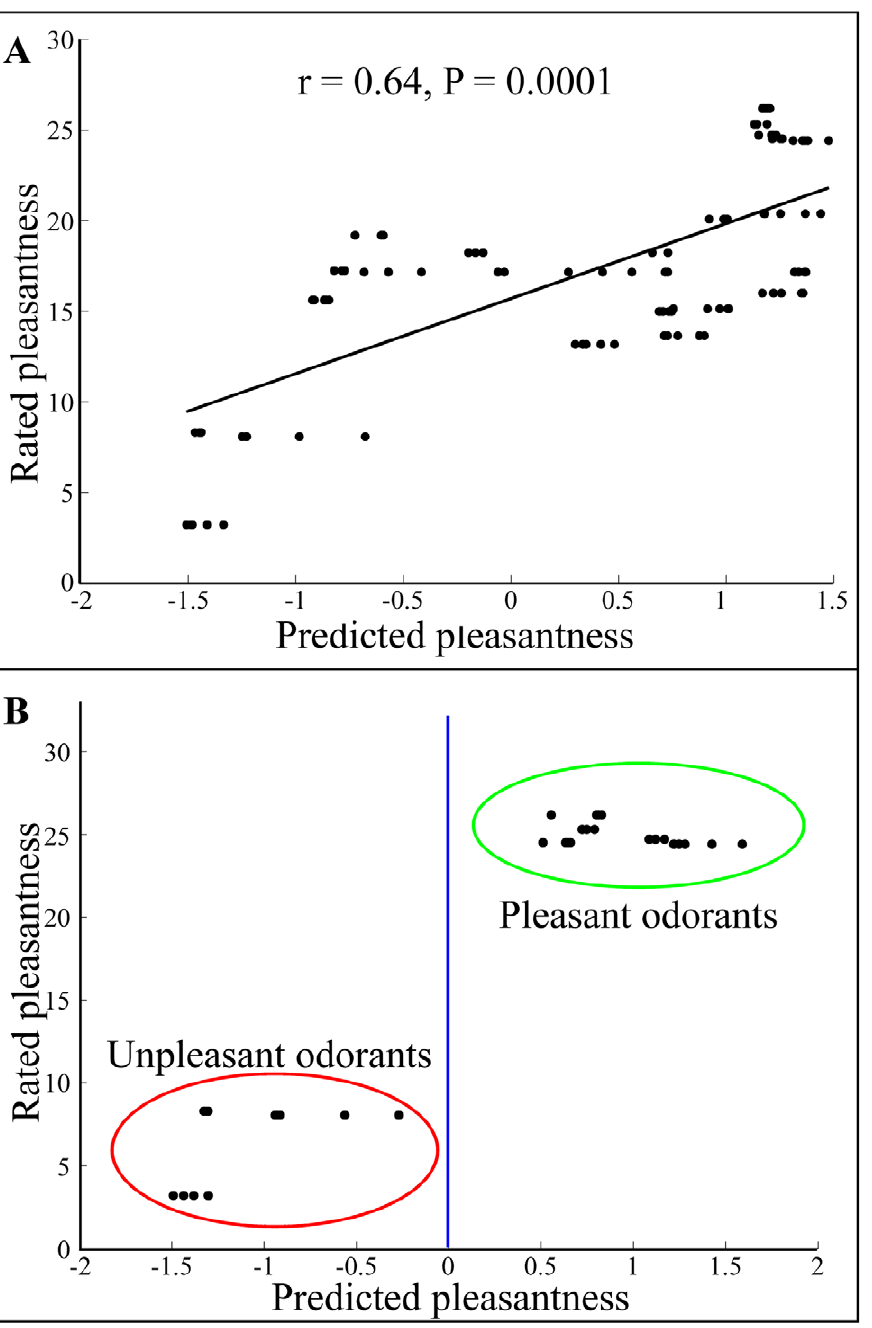
Figure 2. Predicting pleasantness of novel odorants: Essential oils. A. The correlation between the eNose pleasantness prediction values of 22 odorant mixtures (essential oils) and the values obtained from human participants. Each dot represents an eNose measurement (many dots overlay) B. The result of the classification algorithm when removing all odors with medium pleasantness ratings (below and above 1/3 and 2/3 of the pleasantness scale respectively).